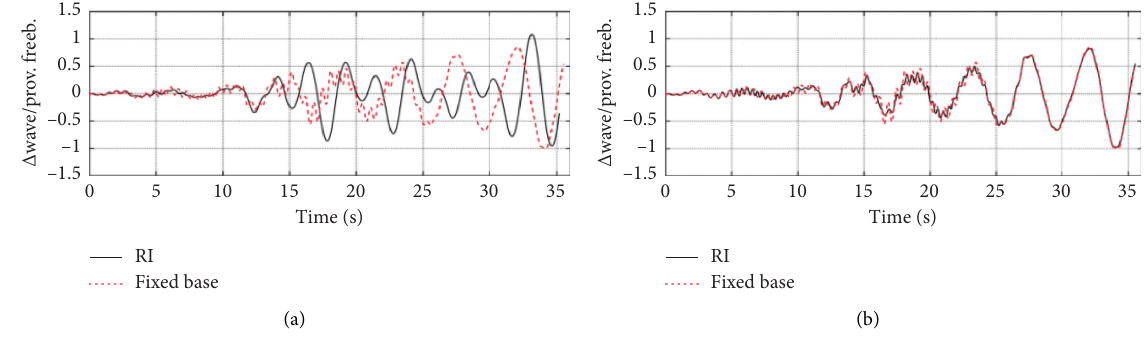
Figure 16: Normalized tank-base (top) and shaft-base (bottom) shear forces for the sample structure with C1 (a) and C2 (b).